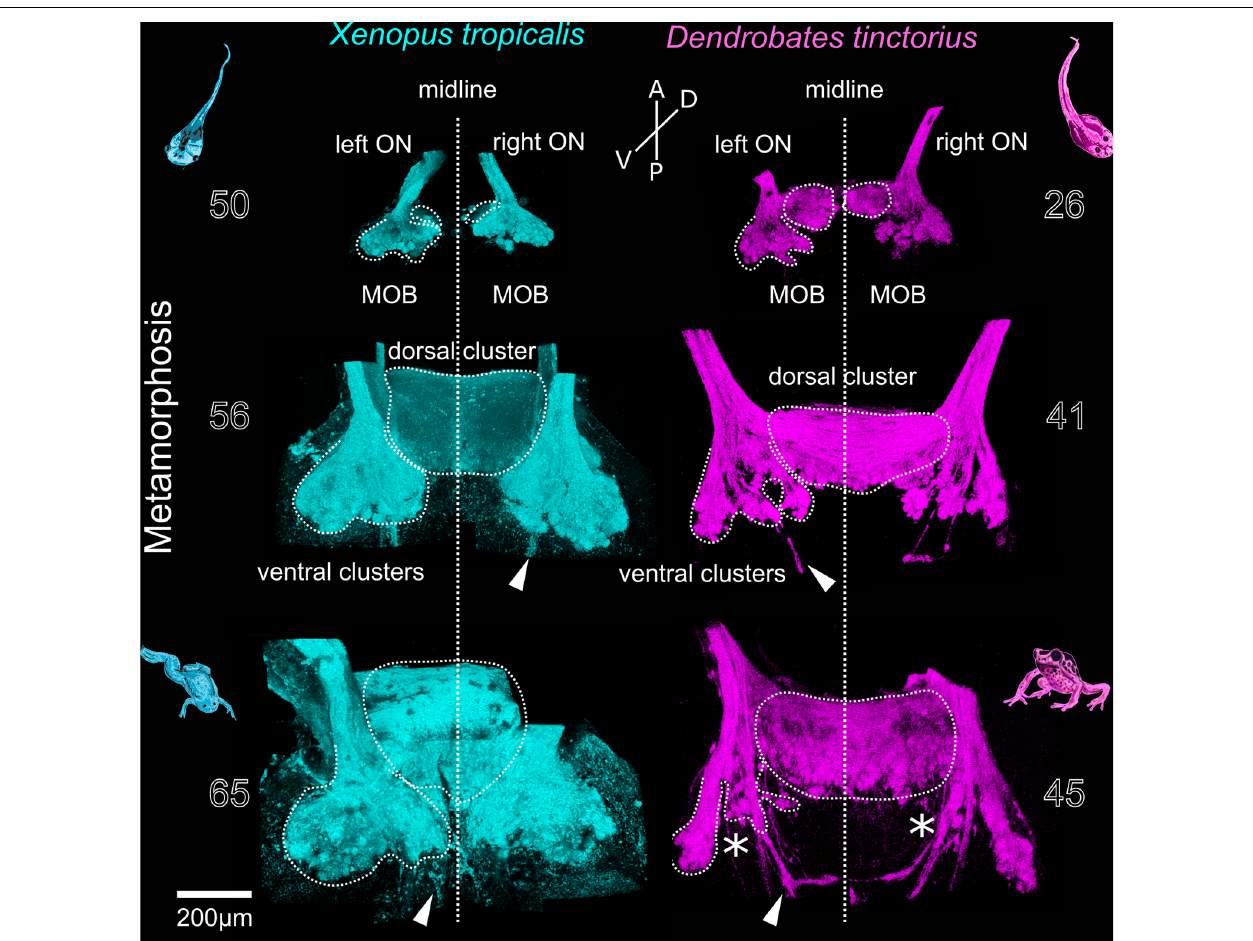
FIGURE 3 | Metamorphotic changes of glomerular clusters in Xenopus tropicalis and Dendrobates tinctorius . Before metamorphosis (top), the left and right glomerular projections in the MOB are separated at the midline (vertical line). During metamorphosis, the dorsomedial components form an unpaired dorsal cluster (middle). In the late phases of metamorphosis (bottom), the ventral glomerular clusters in X. tropicalis are unchanged, while they are reduced in D. tinctorius (asterisks). Arrowheads—extrabulbar fibers. The numbers next to the images indicate the developmental stages after Nieuwkoop and Faber for X. tropicalis and Gosner for D.tinctorius . A, anterior; P, posterior; D, dorsal; V, ventral; ON, olfactory nerve; MOB, main olfactory